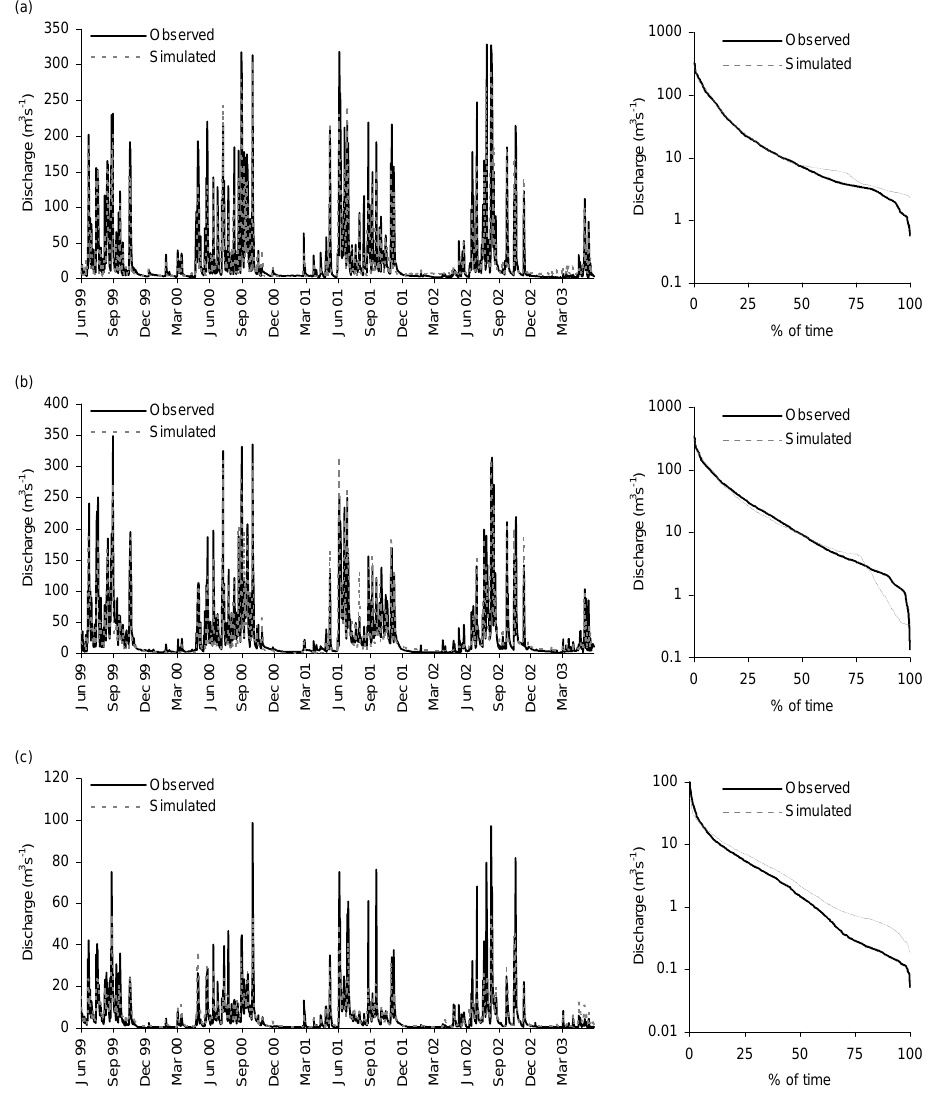
Fig. 2. Comparison (daily flows and flow duration curves) of observed and simulated discharge for the three modelled sub-catchments (June 1999–May 2003) (a) Thoubal, (b) Iril, (c)